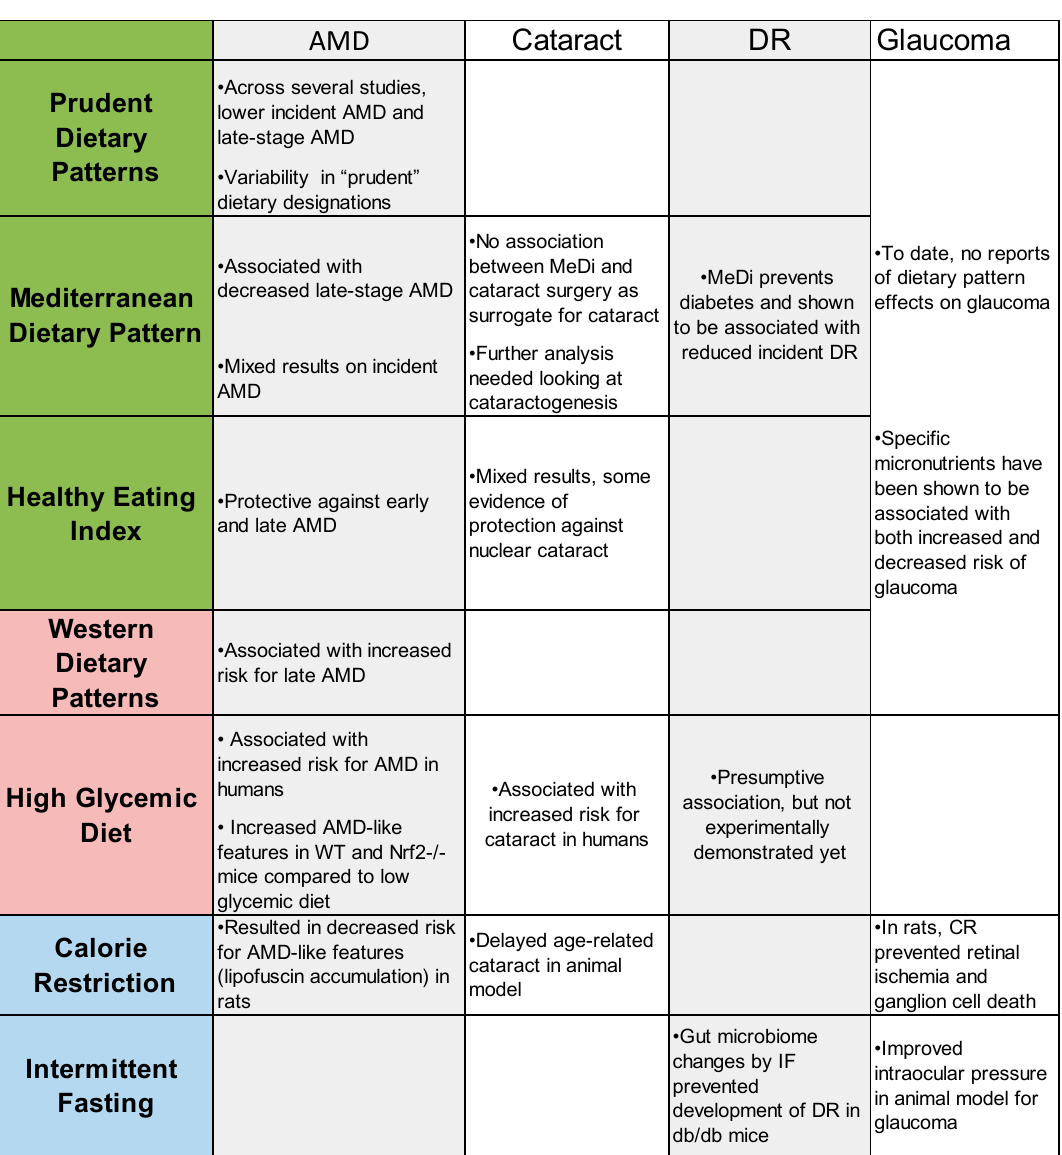
Figure 2. Summary of findings linking dietary patterns or select dietary interventions to age-related eye disease. Abbreviations: CR, caloric restriction; IF, intermittent fasting; DR: diabetic